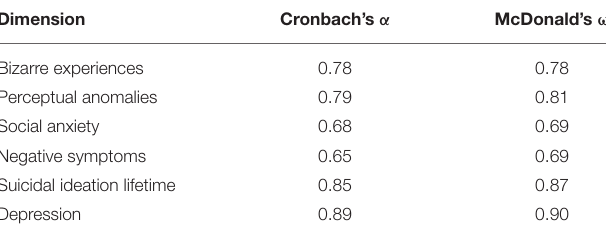
TABLE 1 | Internal consistency values for each subscale.